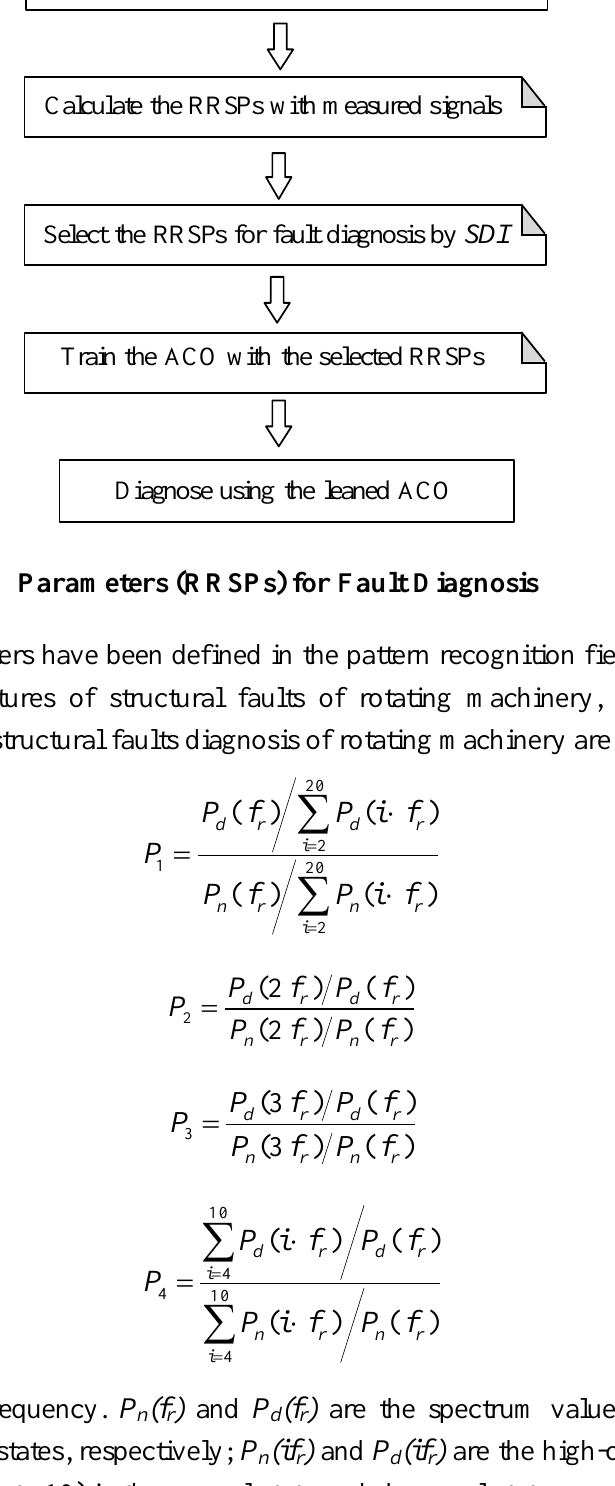
Calculate the RRSPs with measured signals